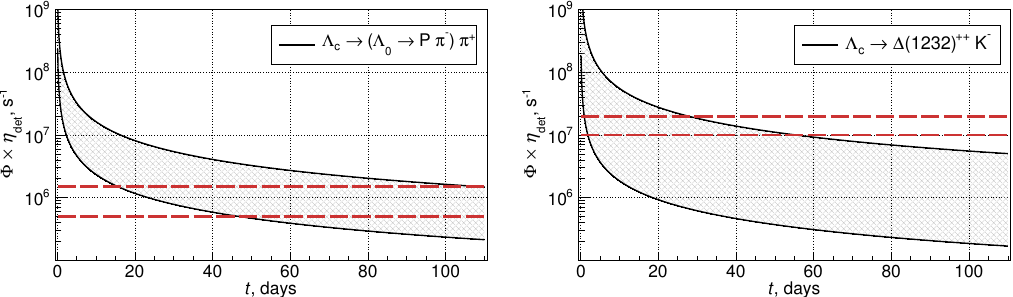
Figure 9 . Flux times detection e(cid:14)ciency (cid:8) (cid:2) (cid:17) det as a function of data taking time for two (cid:3) + decay modes to obtain an absolute error on the gyromagnetic factor g of (cid:6) 0.1. Considering a (cid:13)ux of proton of 5 (cid:2) 10 8 s (cid:0) 1 , the areas between horizontal lines: (0 : 5{2) (cid:2) 10 6 and (1{2) (cid:2) 10 7 correspond to (cid:17) det = (1{3) (cid:2) 10 (cid:0) 3 (typical for the (cid:3) + ! (cid:3) (cid:25) + decay mode) and (2{4) (cid:2) 10 (cid:0) 2 (typical for the c (cid:3) + ! (cid:1) ++ K (cid:0) decay mode), c